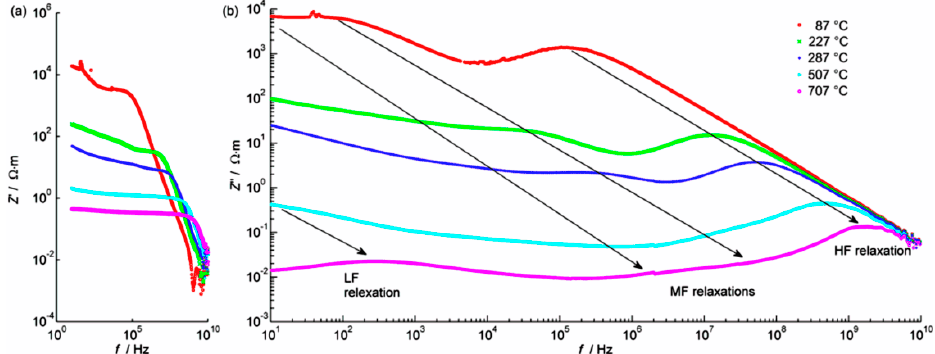
Figure 9. Spectra of ( a ) real Z ′ and ( b ) imaginary Z ʺ parts for a 2SBCY sintered pellet. Arrows indicate (approximately) the shift of the relaxation frequency of several processes with changes in temperature.